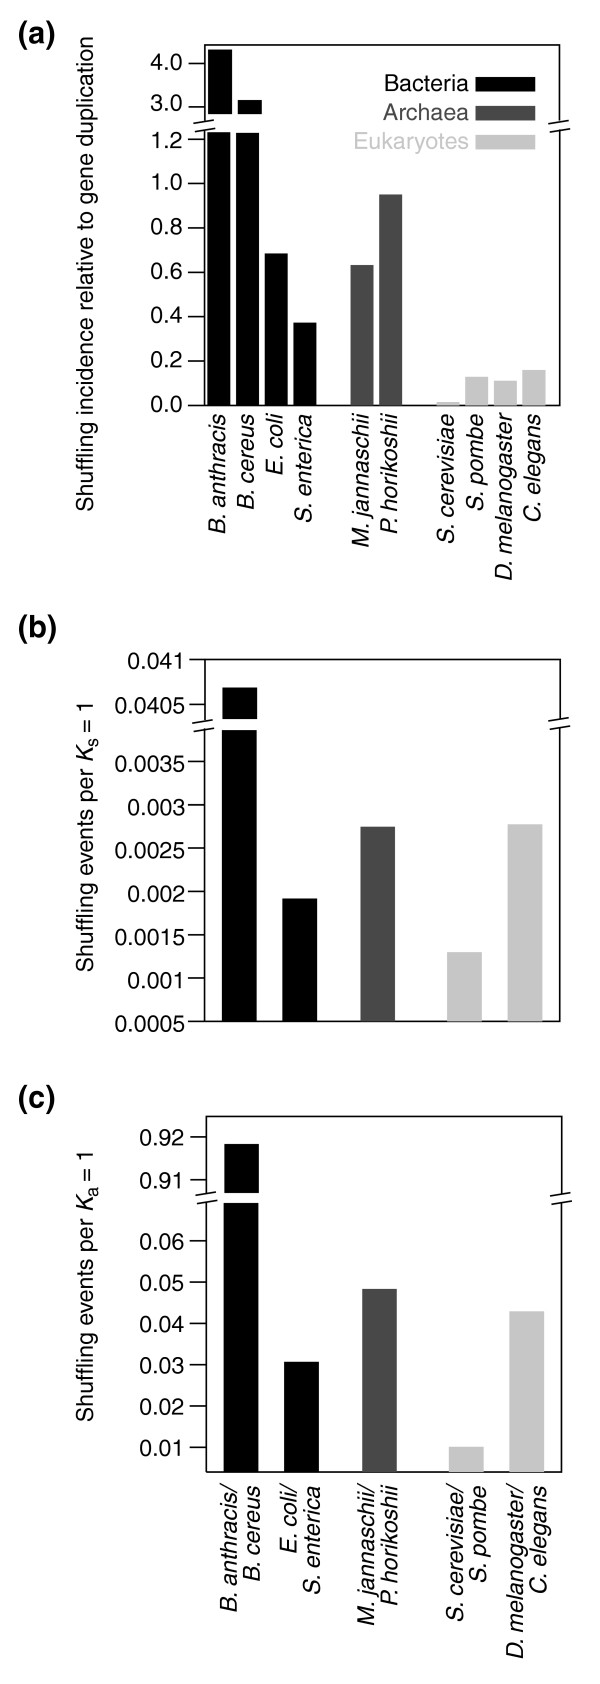
Incidence of gene shuffling relative to various other mutational events. (a) Gene duplication, (b) silent nucleotide substitutions, and (c) amino-acid changing nucleotide substitutions for the species pairs indicated on the horizontal axis. Note the scale breaks on the vertical axes.